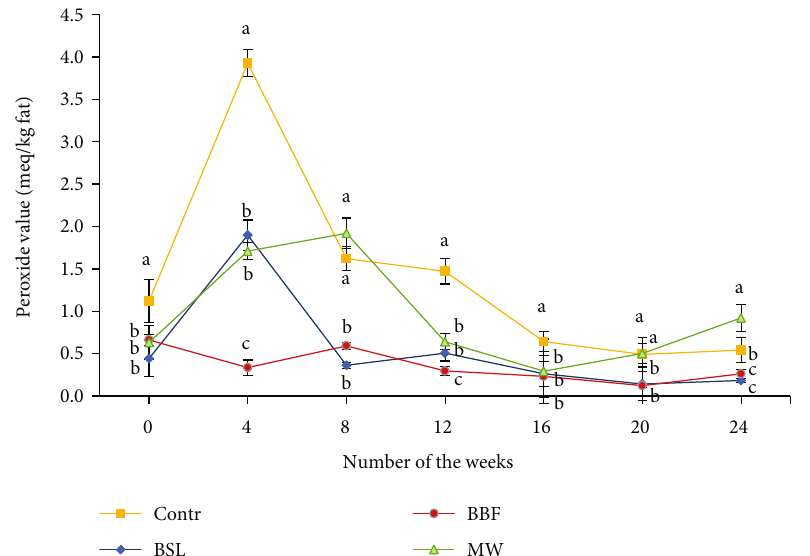
Figure 1: The peroxide value of the diets (meq/kg fat) during a 6-month storage period. The statistical IDs marked with lowercase letters translate into a di ff erence between treatments at the same time at the signi fi cance level of p < 0 : 05 .